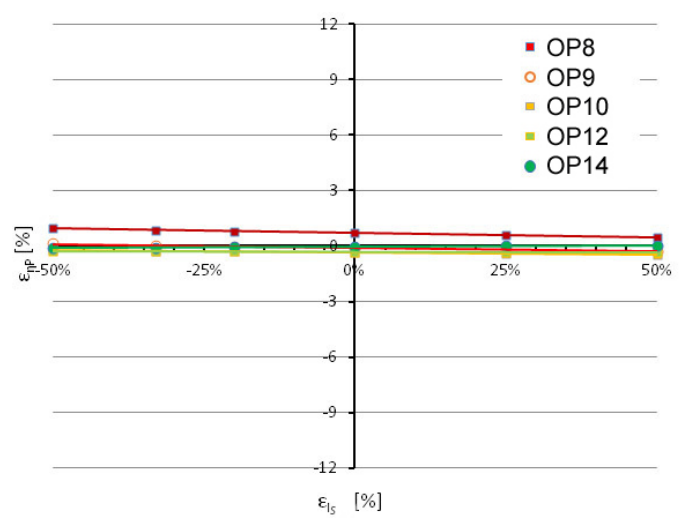
Figure 14. The algorithm sensitivity analysis regarding the determination of the pump efficiency (cid:101) η or deviations in the length of the suction line (cid:101) l P flange for the five operating points: OP8, OP9, OP10, OP12 and